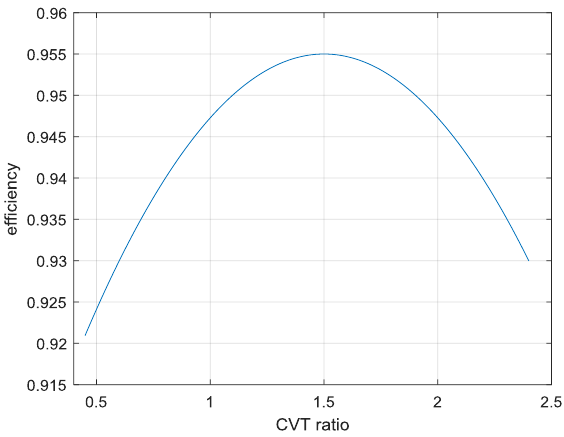
Figure 10. CVT efficiency profile with respect to the CVT ratio [20].